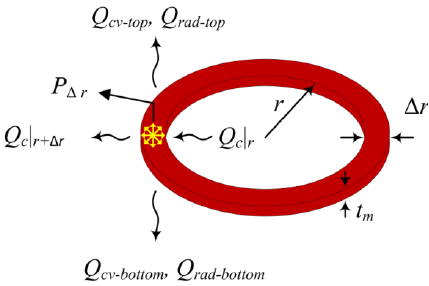
Figure 2. Heat flows for a thin cylindrical